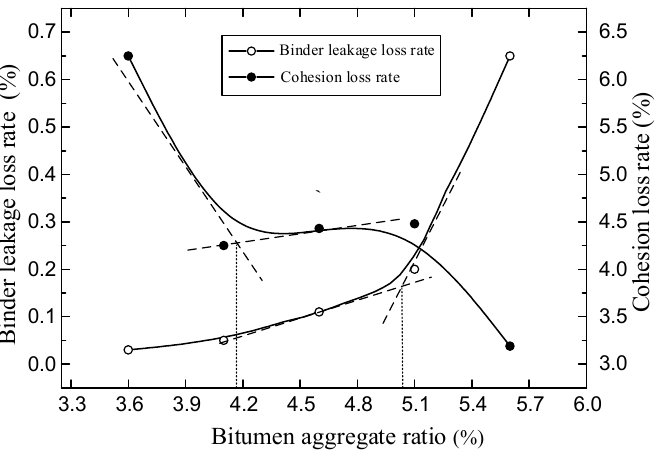
Figure 6. Relationships between binder leakage loss rate, cohesion loss rate and bitumen/aggregate ratio.